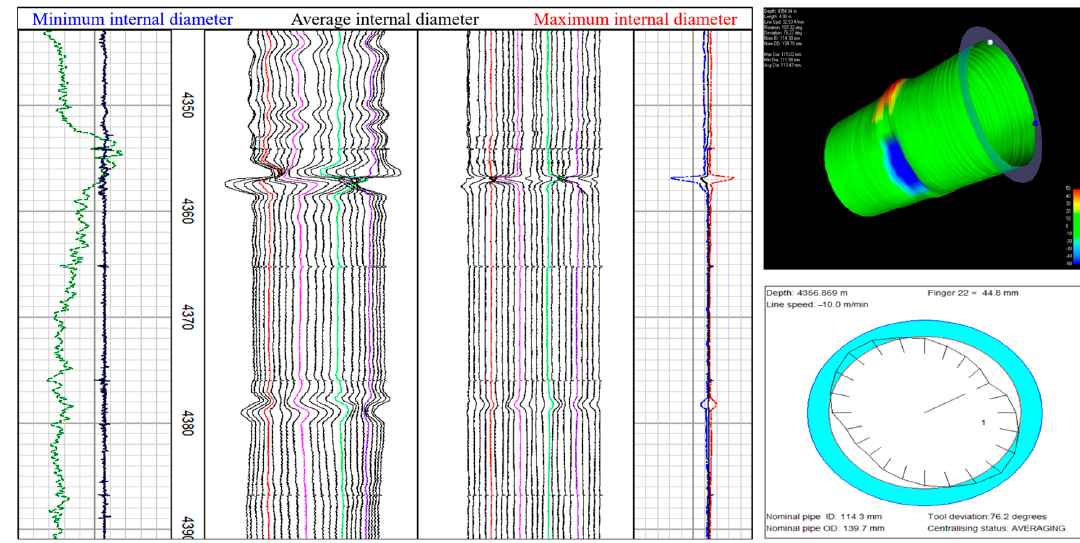
Figure 4. Deformation morphology of shale gas horizontal casing.